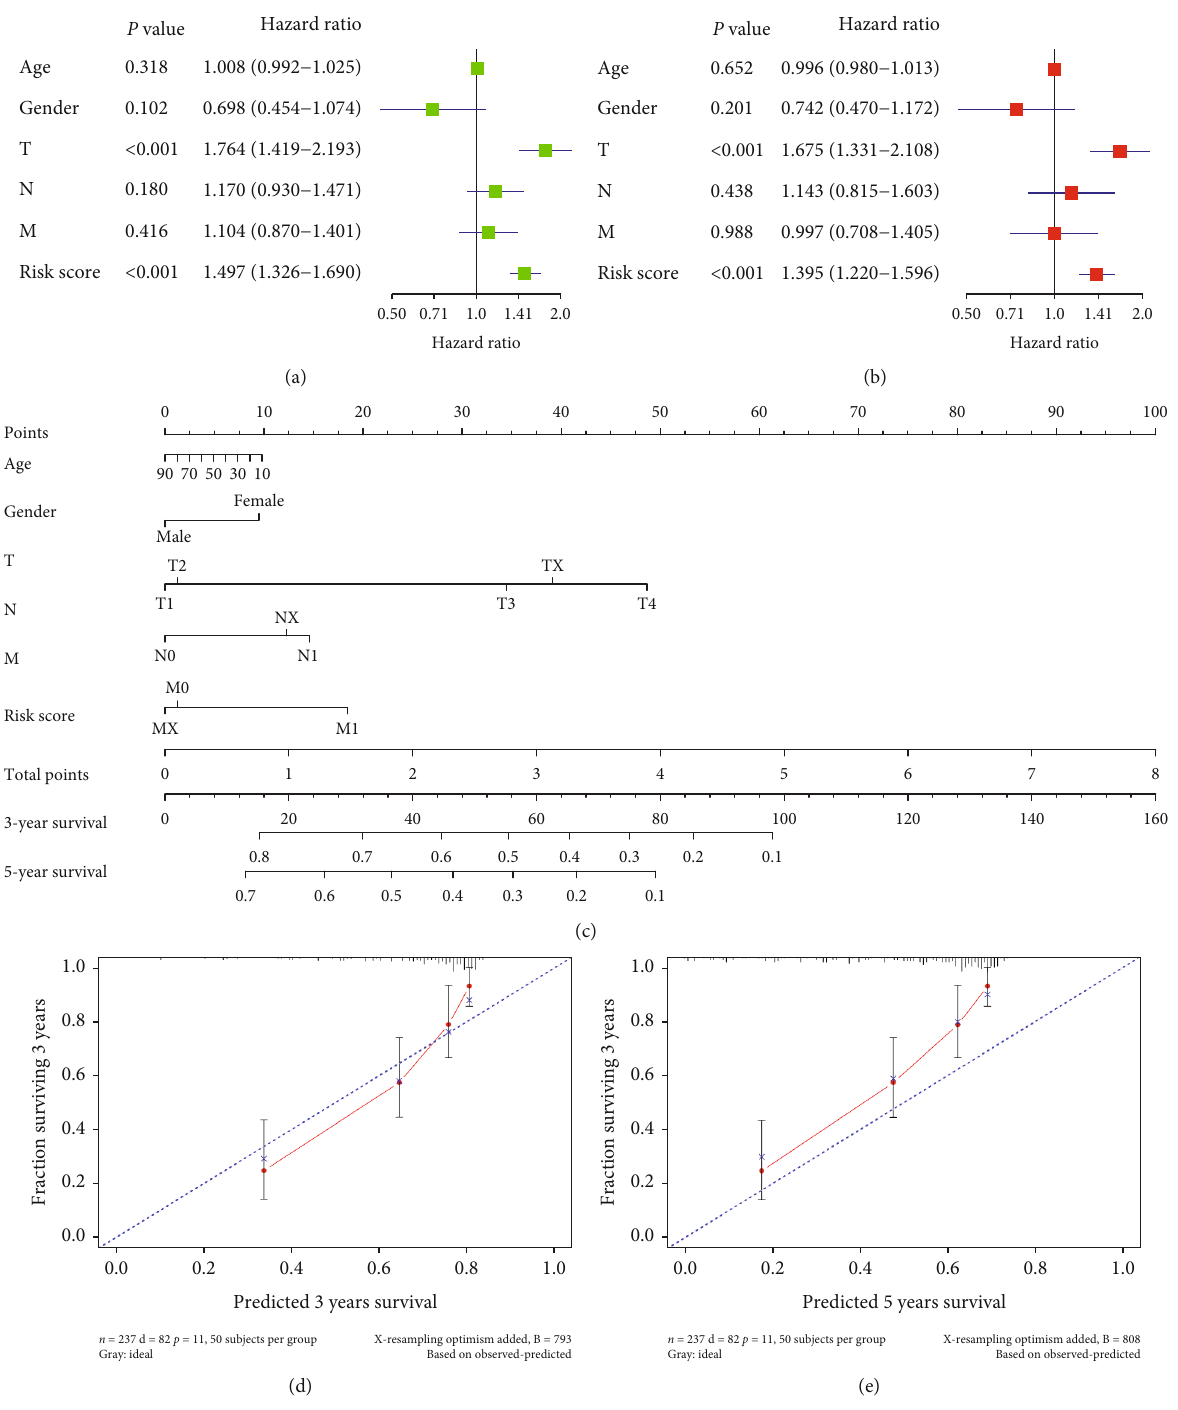
Figure 6: Correlation analysis of risk scores and clinical factors with the prognosis of HCC patients and construction and assessment of nomograms. Forest plots of univariate Cox regression analysis (a) and multivariate Cox regression analysis (b) of risk score combined with clinical factors. (c) Nomogram of risk score combined with clinical factors to predict 3- and 5-year survival of patients; calibration curve for nomogram prediction of 3-year survival (d) and 5-year survival (e) of HCC